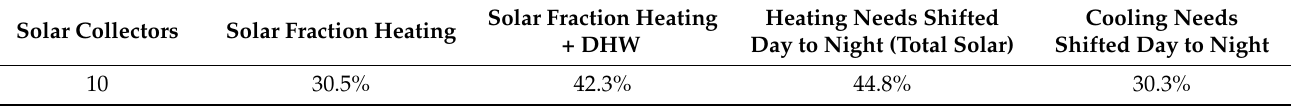
Table 6. Solar contribution and energy needs shifted from day to night.